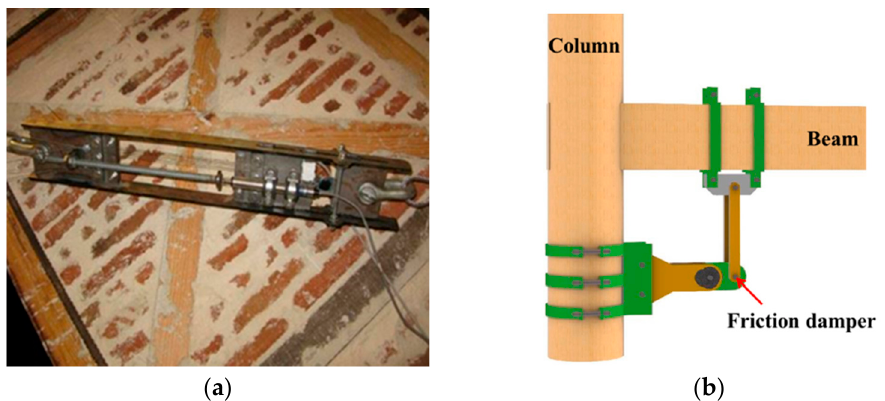
Figure 17. Retrofitting a timber frame wall using ( a ) super-elastic damper [125] or ( b ) friction damper